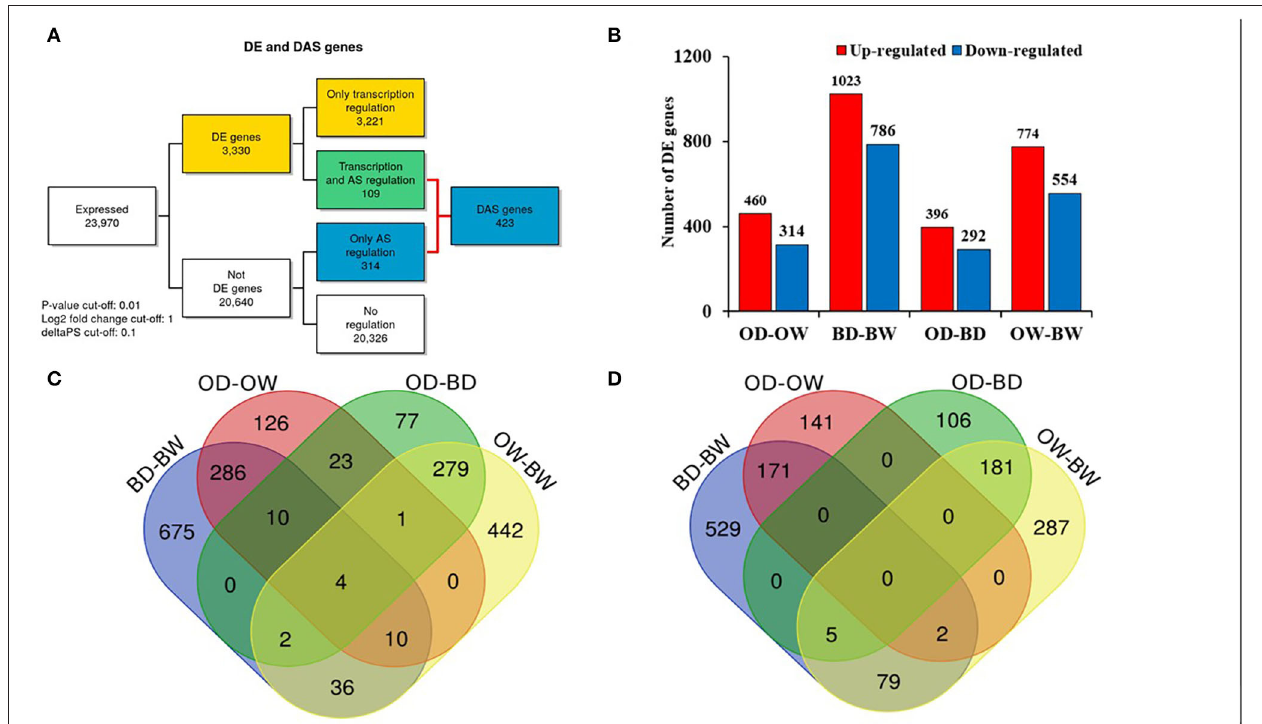
FIGURE 5 | Differential gene and alternative splicing analysis in two barley genotypes under progressive drought. (A) Number of genes regulated only by transcription (DE), only by alternative splicing (DAS) and by both transcription and alternative splicing (DE + DAS) across barley contrast groups (OD-OW, BD-BW, OW-BW, and BD-OD). (B) Number of up- and down-regulated DE genes in the different contrast groups. (C) Venn diagram of the up-regulated genes of the different contrast groups (OD-OW, BD-BW, OD-BD, and OW-BW). (D) Venn diagram of the down-regulated genes of the different contrast groups (OD-OW, BD-BW, OD-BD, and OW-BW).